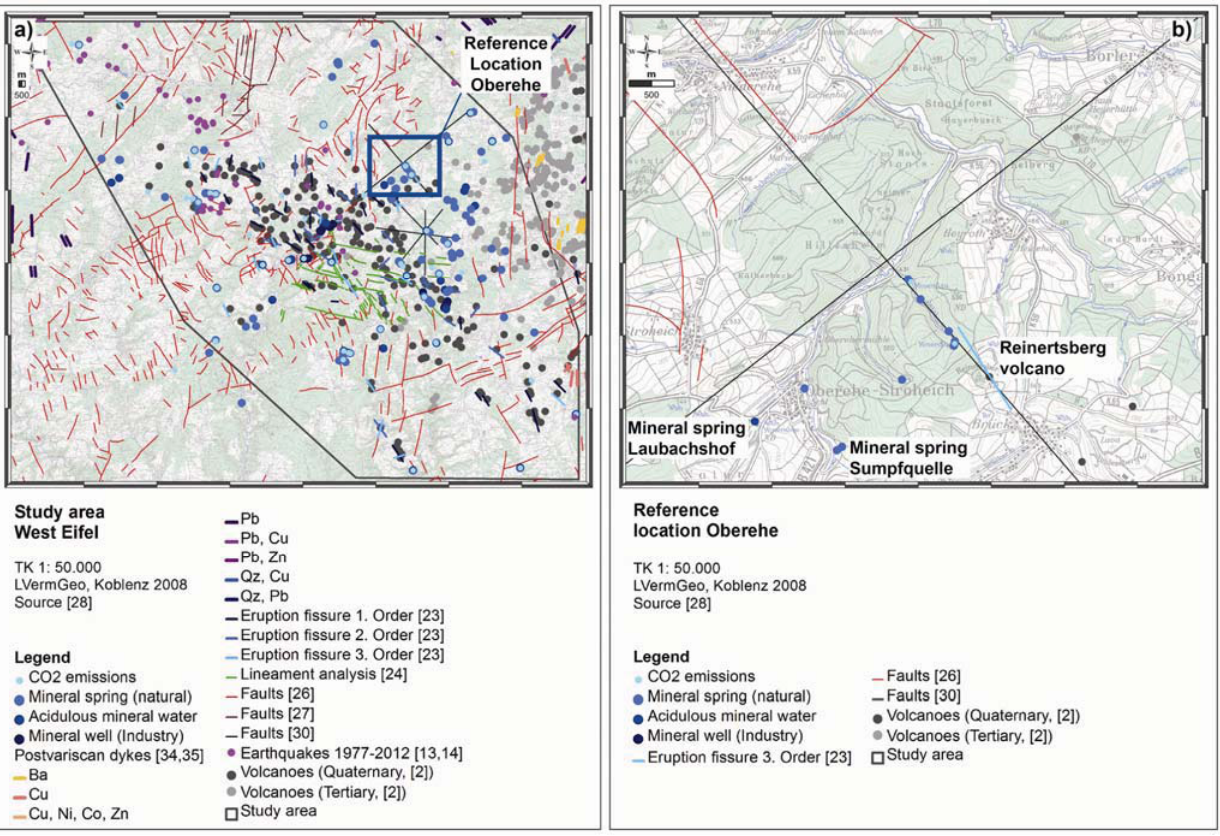
Figure 2. Tectonic features of the 1,140 km² study area ( a ) and of the reference location Oberehe ( b ) according to the current state of knowledge. At Oberehe it is visible, that knowledge on the tectonic regime [26,30] is limited and incomplete due to the coverage of tectonic faults by soil cover and vegetation (forest